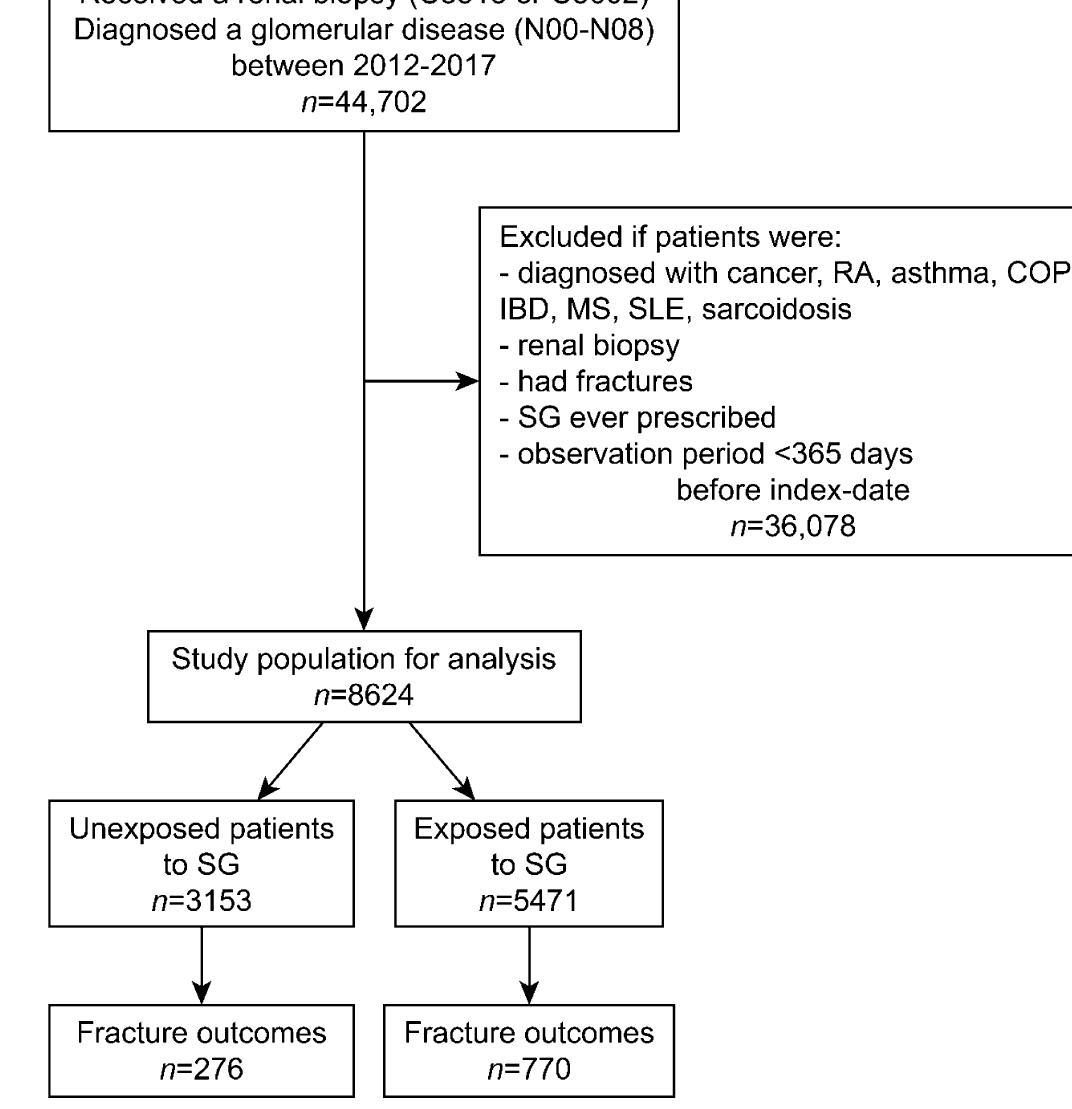
Figure 1. The flow chart of the study population. RA rheumatoid arthritis, COPD chronic obstructive pulmonary disease, IBD inflammatory bowel disease, MS multiple sclerosis, SLE systemic lupus erythematosus, SG systemic